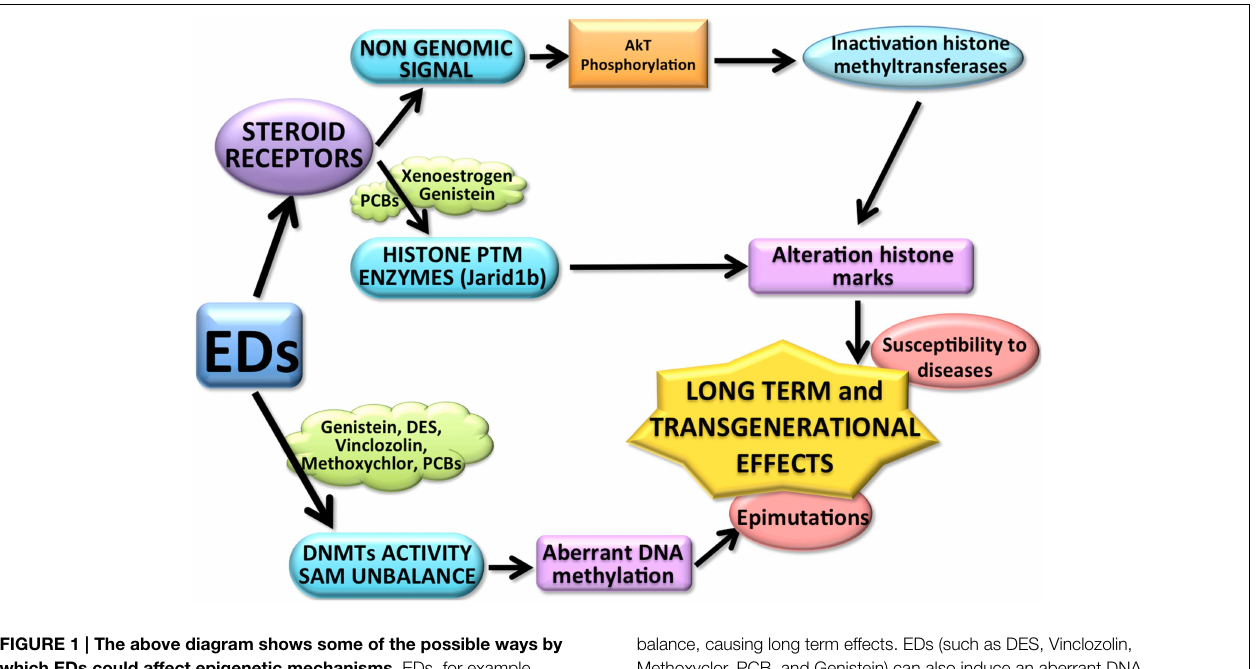
FIGURE 1 | The above diagram shows some of the possible ways by which EDs could affect epigenetic mechanisms. EDs, for example PCBs, (through the interaction with the steroid receptors) might affect directly histone post-translational modification (PTM) enzymes but also inactivate the histone modification enzymes through a non-genomic signal pathways (for example Genistein). Both mechanisms can affect the histone modification